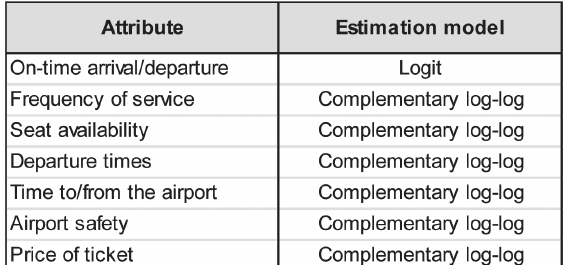
Table VI: Summary of significant models